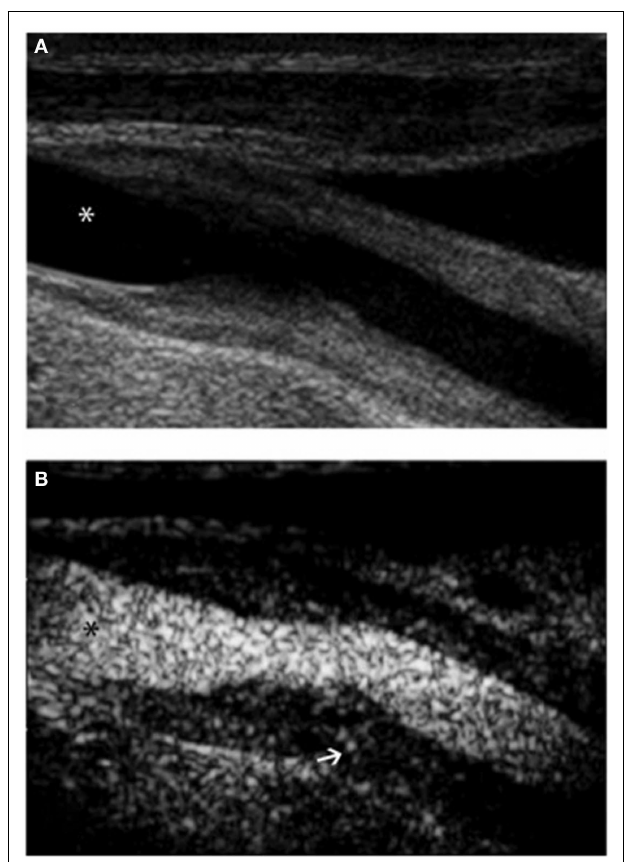
FIGURE 2 | Ultrasound examination of right proximal common carotid artery of a patient affected byTakayasu arteritis . B-mode ultrasound (A) shows long, smooth concentric thickening of the arterial wall. Contrast-enhanced ultrasound (B) using Optison (GE Healthcare, Little Chalfont, UK), a contrast media made up of human albumin microbubbles filled with perflutren, improves definition of the lesion border. Extensive enhancement can be seen within the vessel wall (arrow). In both panels, asterisk marks the vessel lumen.